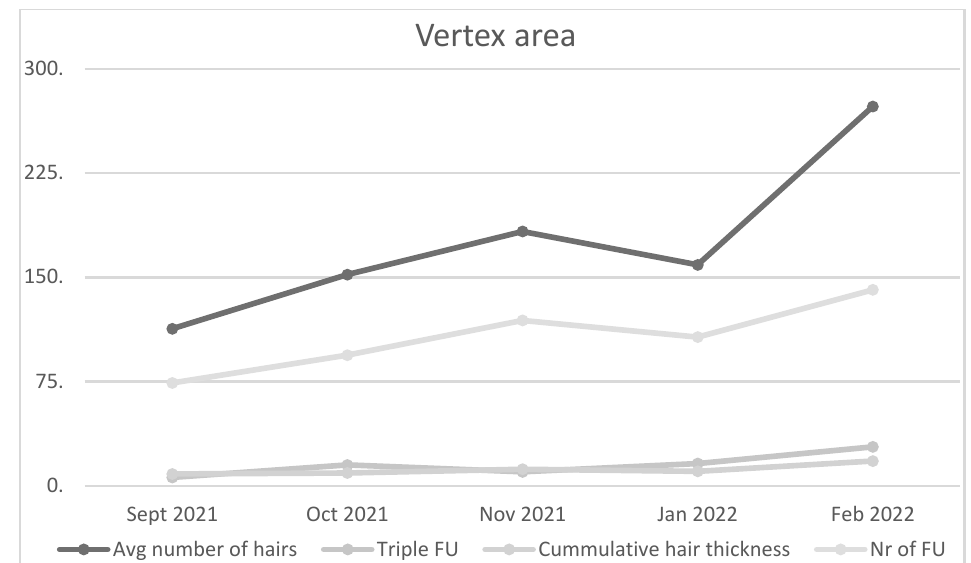
Figure 2. Average number of hairs, Average hair shaft thickness, Thick hairs, Triple FU, Cumula- tive hair thickness, and Number (Nr) of follicles (F) increased in the vertex area of the first patient.